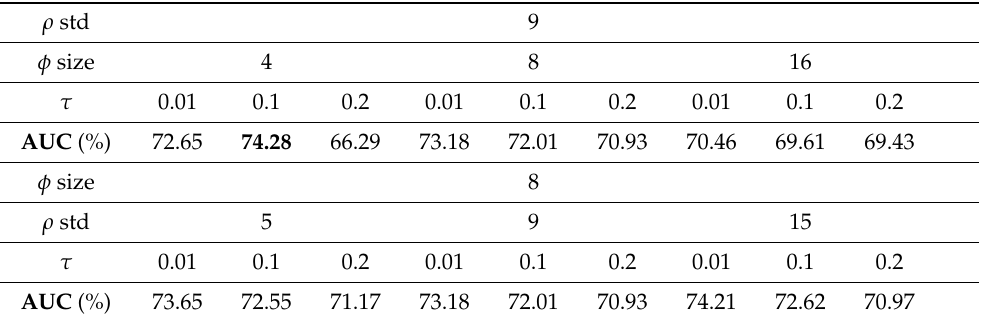
Table 3. CASME II dataset. AUC (area under the ROC curve) for the proposed method with different parameter settings. The size of the spatial filter ρ and of the temporal filter φ in Equation (1), along with the threshold τ used in the removal of instabilities (step 5 of the Algorithm), have been considered. ( Top ) For fixed ρ standard deviation (std), AUC is evaluated for variable φ size and τ ; ( bottom ) for fixed φ size, AUC is evaluated for variable ρ standard deviation and τ . The best result is in bold. ρ std 9 φ size 4 0.01